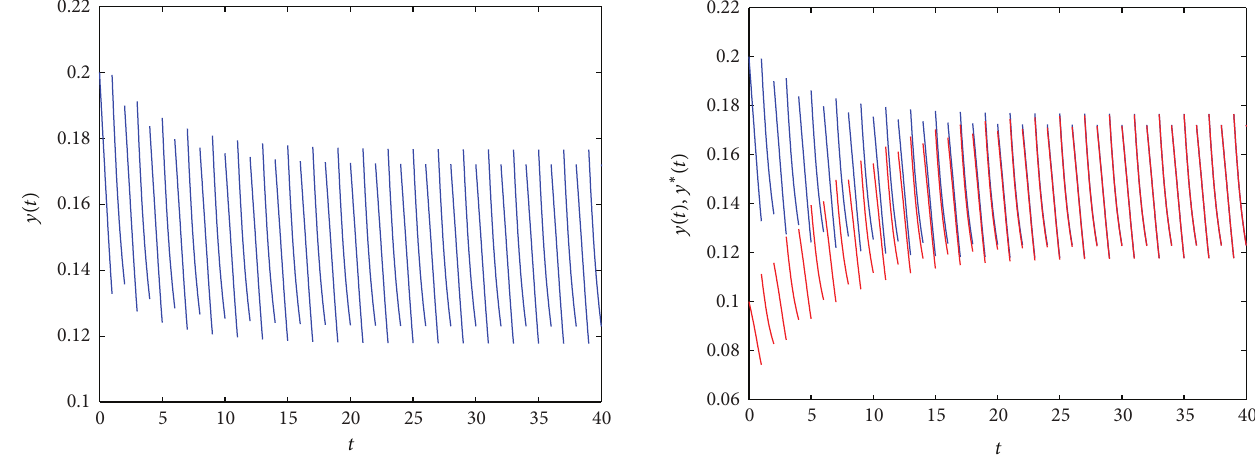
Figure 1: Permanence of system (4a) and (4b) with 𝑦(0) = 0.2 , 𝑎(𝑡) = −0.11 + 0.1 cos 𝜋𝑡 , 𝑏(𝑡) = 1.4 + 0.1 sin 𝜋𝑡 , 𝑐(𝑡) = 0.11 + 0.1 cos 𝜋𝑡 , 𝑑(𝑡) = 1.5 + cos 𝜋𝑡 , 𝛾 series of species 𝑦 for 𝑡 ∈ [0,40] .